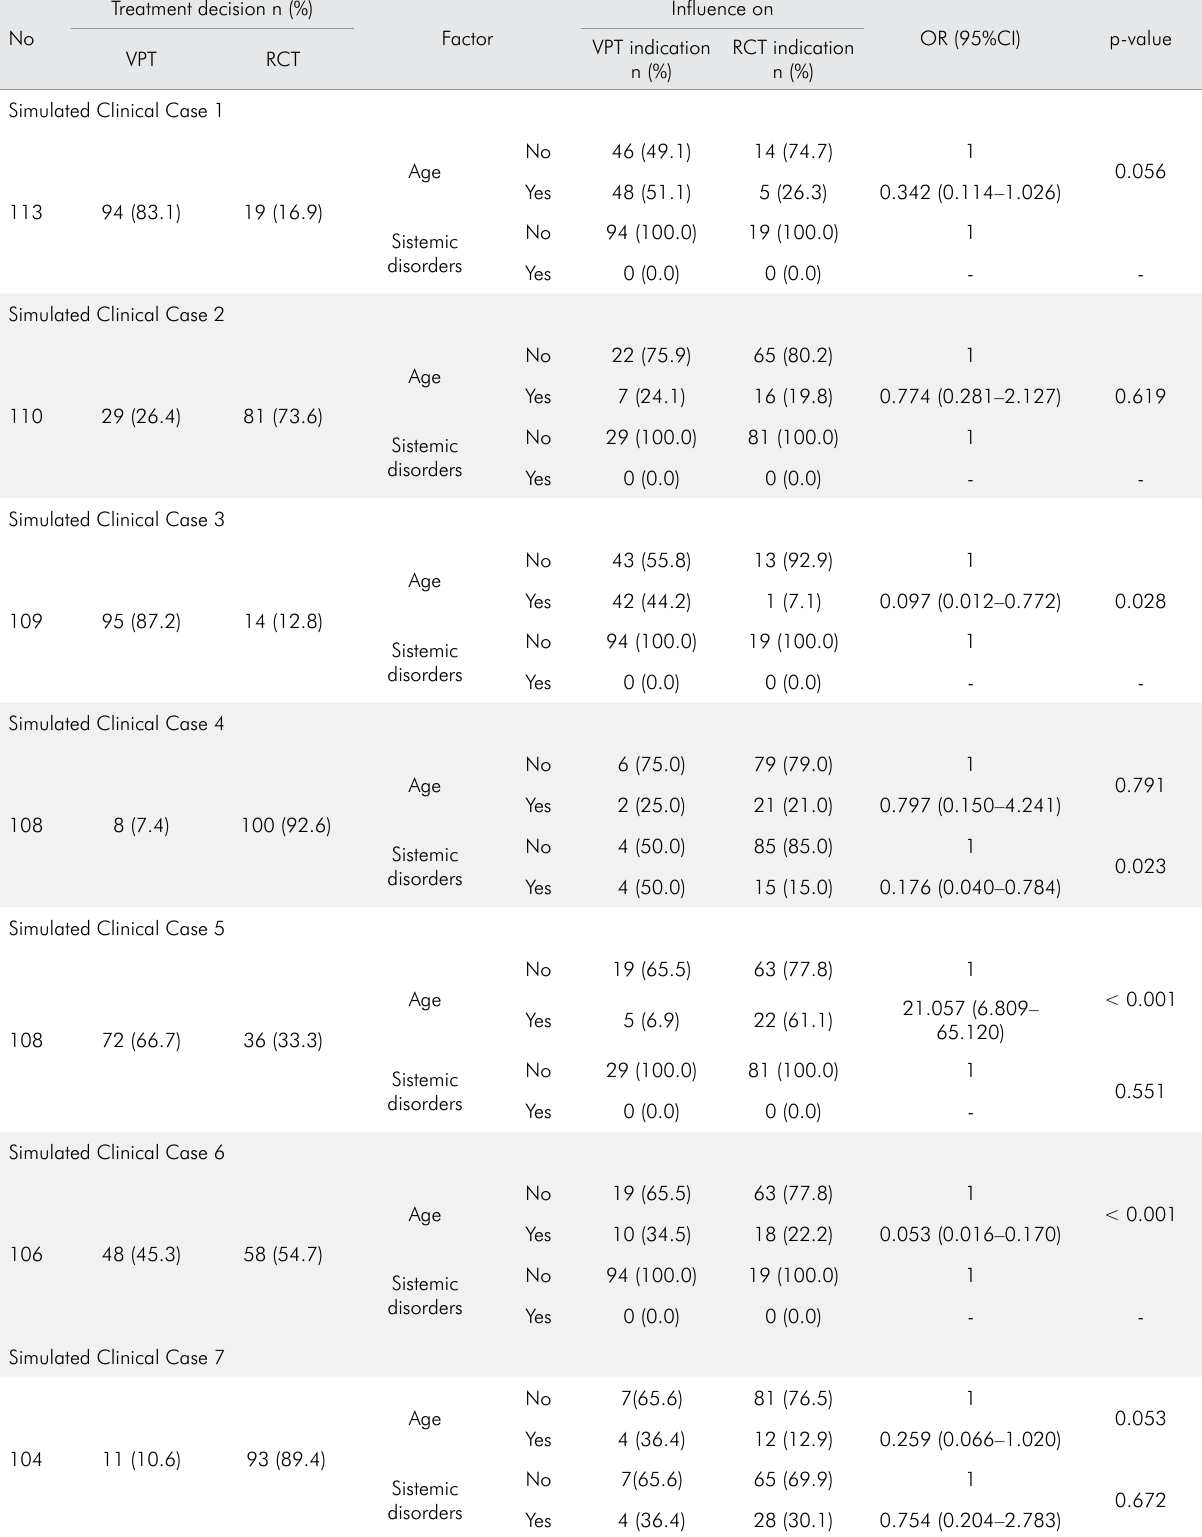
Table 3. Patient’s systemic conditions: bivariate logistic regression model showing significant predictors (p < 0.05), odds ratio (OR), and 95% confidence interval (95%CI) for the preference of root canal treatment (RCT) over vital pulp therapy